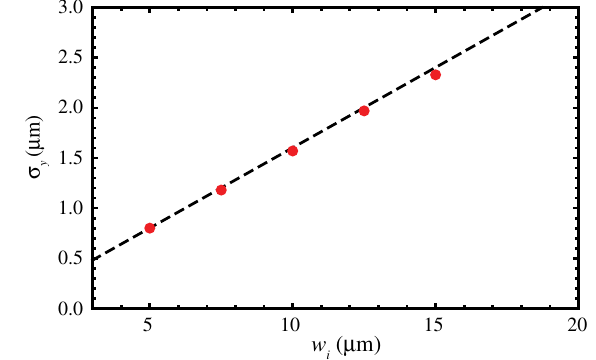
FIG. 4. The rms width of the transverse distribution of ionized electrons versus laser spot size w ¼ 0 . 4 μ m ionizing a krypton gas, Kr 8 þ → Kr 9 þ and λ i ¼ 230 eV). The points are PIC simulations using WARP , ( U I and the dashed line is the analytic expression Eq.